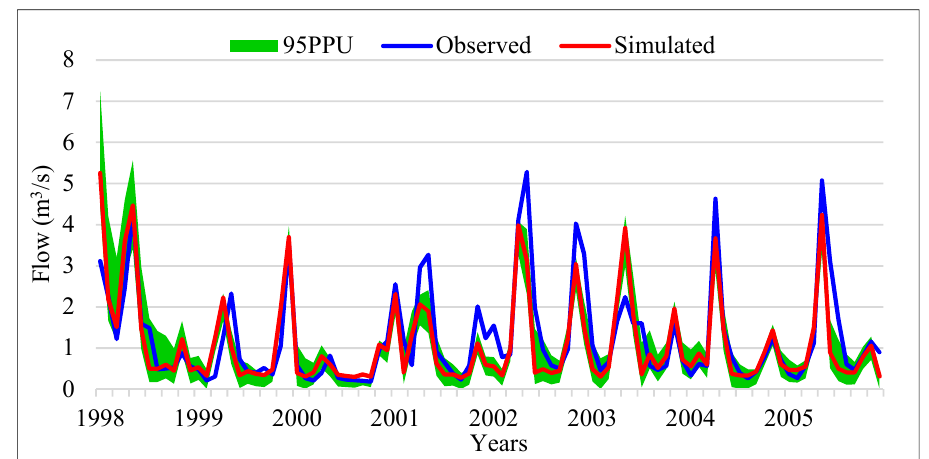
Figure 4. Monthly streamflow calibration results for gauging station 4CB05.